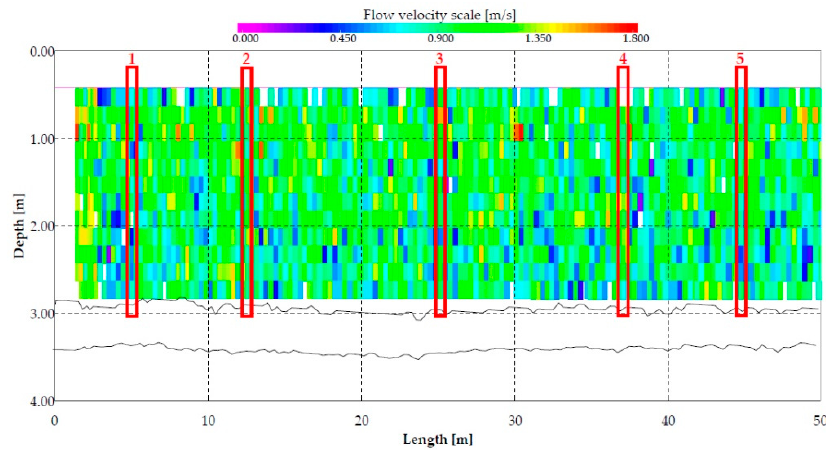
Figure 7. The subsection of the flow velocity contour profile measured with ADCP and used for verification (m01), corresponding to the model’s XS-US.